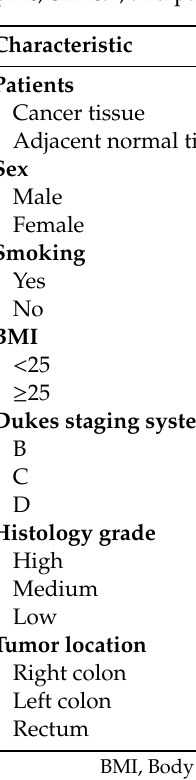
Table 3. Demographic, clinical, and pathological characteristics of the